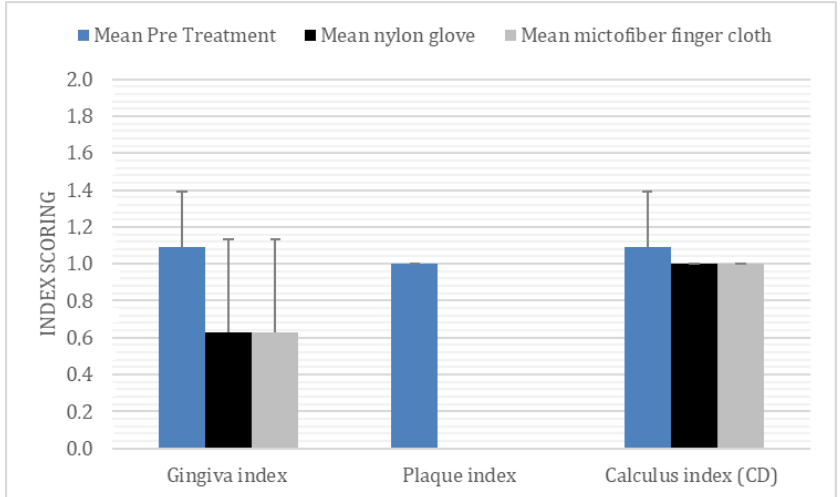
Figure 2. Mean ± SD before and after 35 days of daily dental cleaning with nylon glove or microfiber finger cloth n 11 beagle dogs.